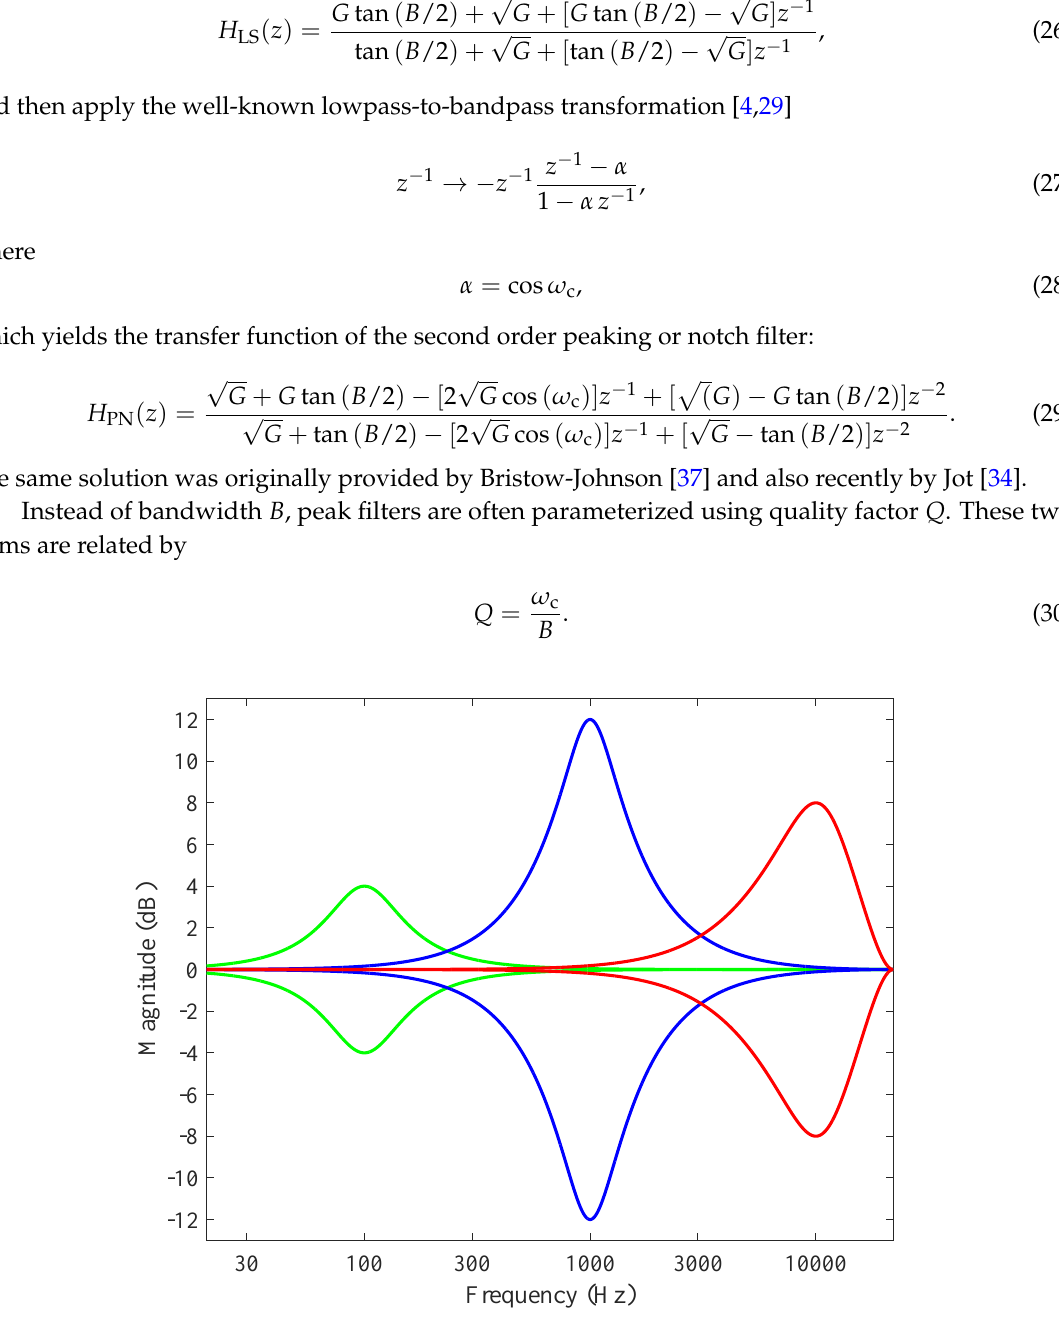
Figure 5. Magnitude responses of peak and notch filters at center frequencies 100 Hz (green), 1000 Hz (blue), and 10,000 Hz (red), when Q = 1. The gains of the peak and notch filters are complementary, i.e ., G and 1/ G ,